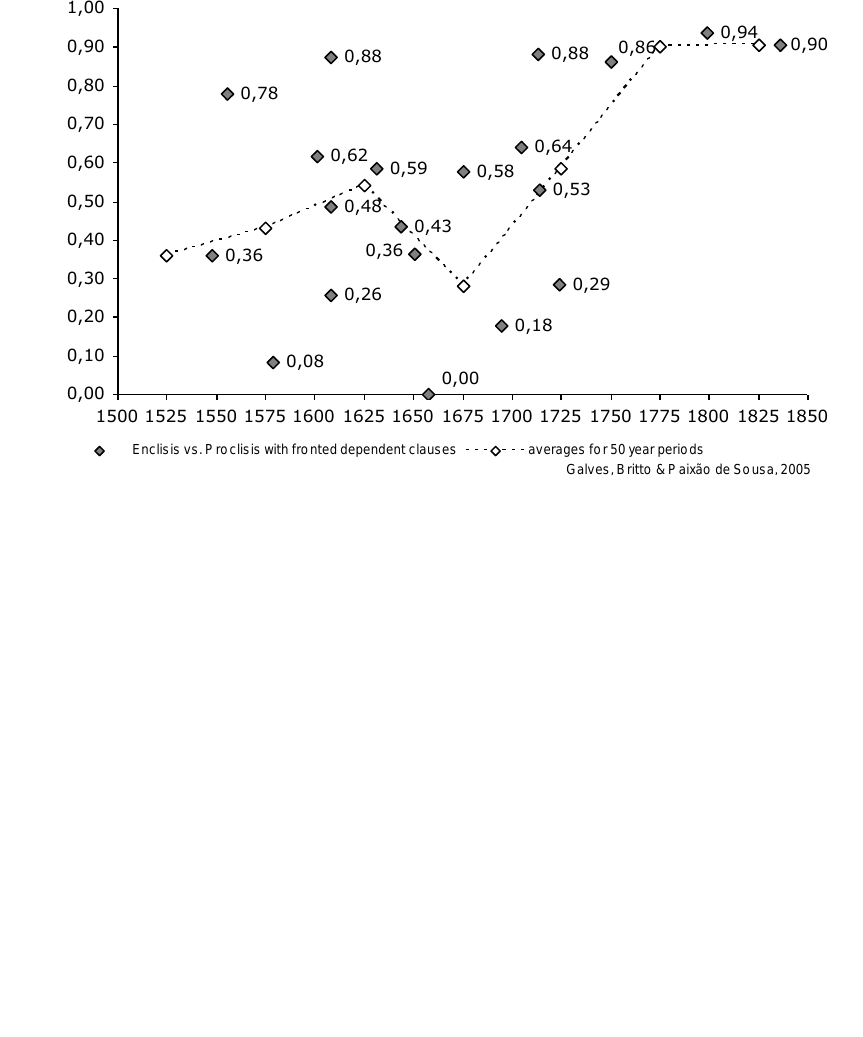
Figure 5 : Enclisis versus Proclisis with fronted dependent clauses